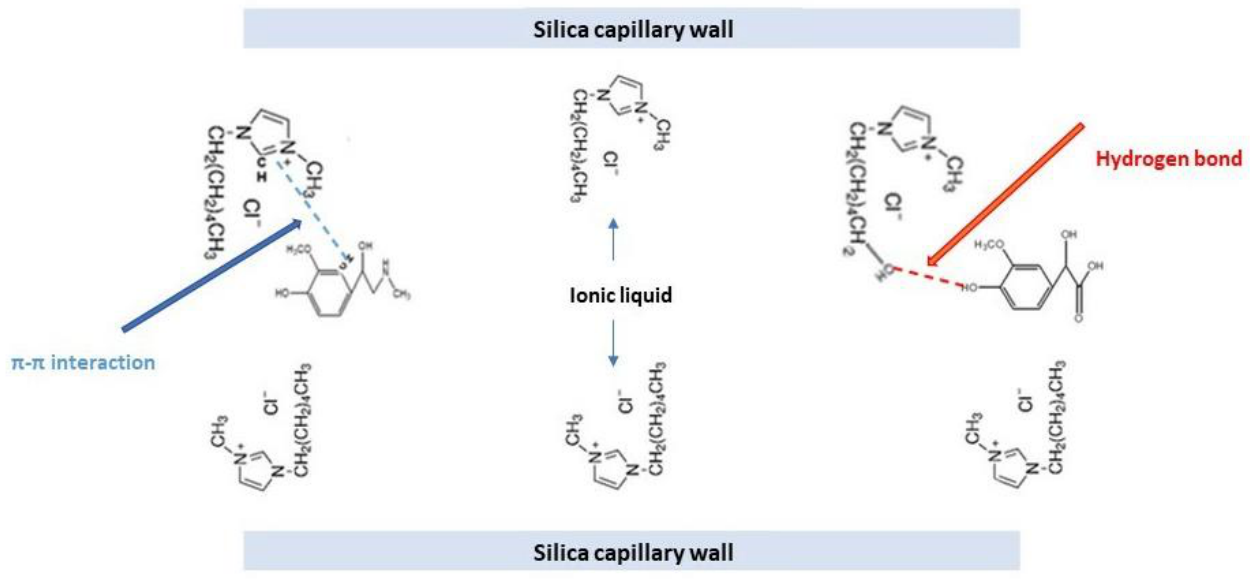
Figure 1. Schematic of separation within the capillary containing [HMIM + Cl − ] and possible interac- tion with analytes.